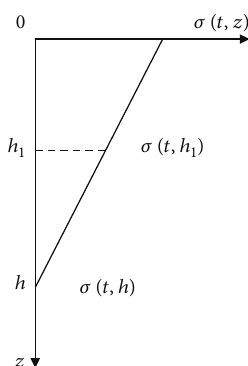
Figure 4: Relationship between of the additional stress and